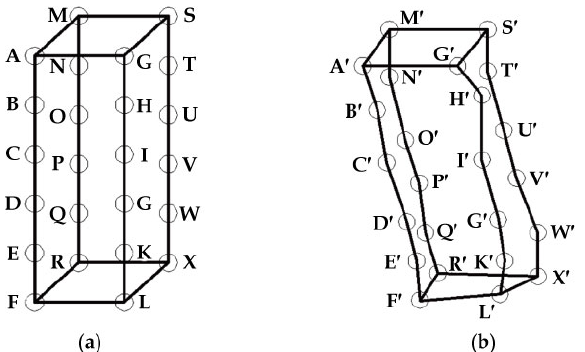
Figure 3. Fertilizer deformation schematic diagram: ( a ) fertilizer state before covering soil; ( b ) fertilizer state after covering